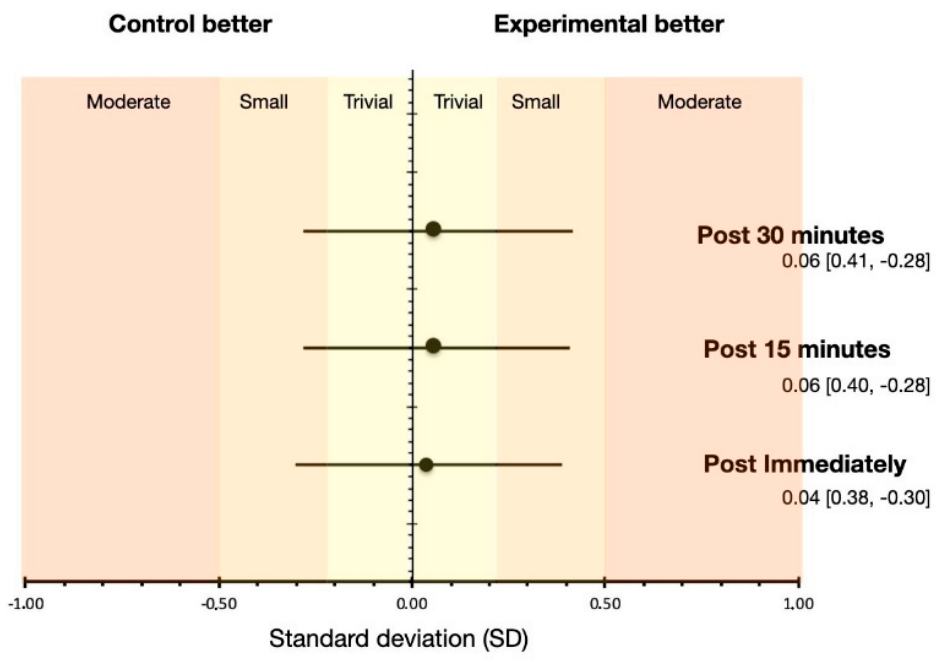
Figure 6. Effect size (ES) in each of the comparisons of the time variable (i.e., post immediate, post-